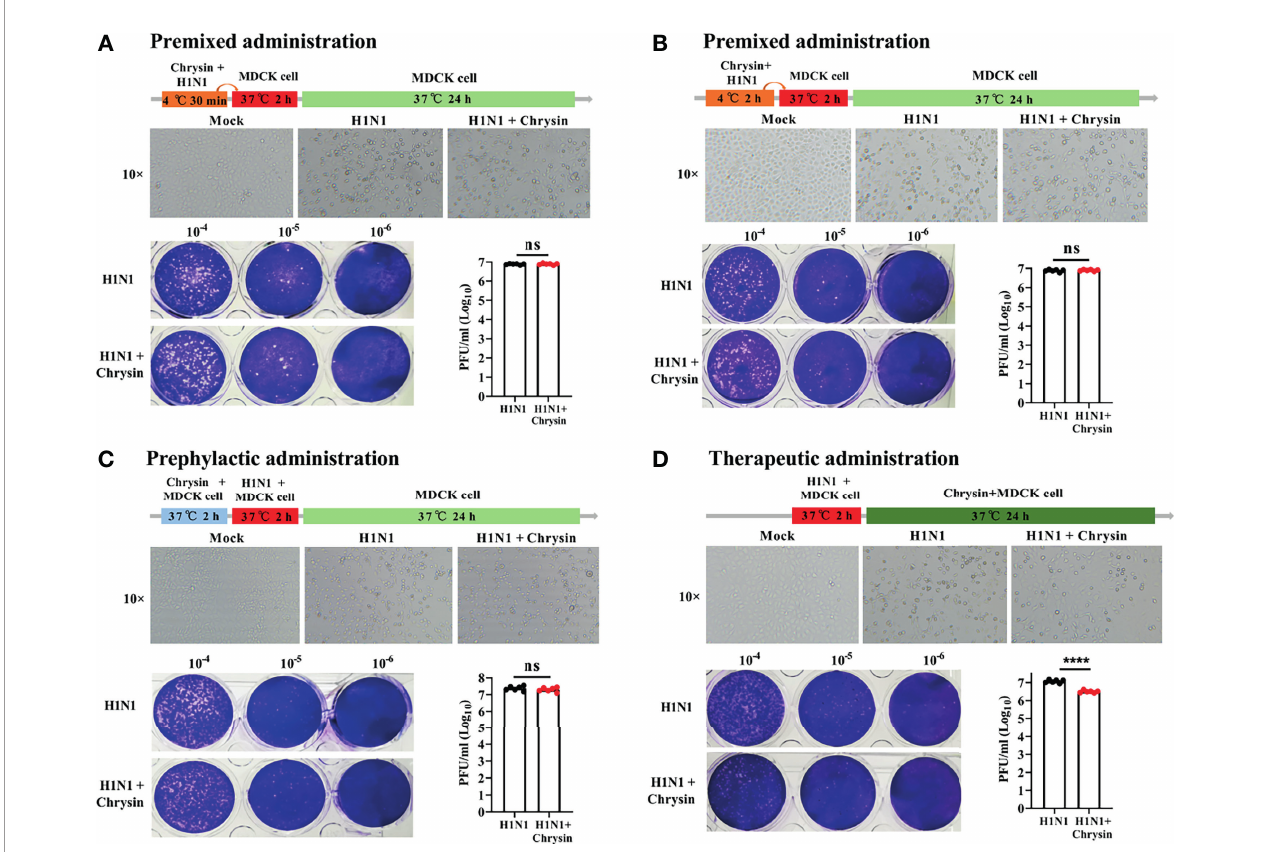
FIGURE 4 | Premixed, prophylactic, and therapeutic ef fi cacy of chrysin against the H1N1 in fl uenza virus. (A, B) Premixed administration. Chrysin (8 m M) and A/PR/ 8/34 (H1N1) virus (MOI = 0.5) were mixed and incubated at 4°C for 30 min (A) or 2 hours (B) , and then the mixture was inoculated onto MDCK cells at 37°C. After 2 hours of incubation, the supernatant was removed and replaced by medium for culturing 24 hours. CPE was observed under a microscope, 10 × original magni fi cation (upper panels). The Viral titer was detected by plaque assay (lower panels). (C) Prophylactic administration. MDCK cells were incubated with chrysin (8 m M) for 2 hours before being challenged with A/PR/8/34 (H1N1) virus (MOI = 0.5), after which the supernatant was removed and supplemented with fresh medium for culturing another 24 hours. CPE and viral titer were assessed using a microscope (upper panel) or a plaque test (lower panel), respectively. (D) Therapeutic administration. MDCK cells were infected with A/PR/8/34 (H1N1) (MOI = 0.5) at 37°C for 2 hours, then the supernatant was removed and cultured with new medium in the presence or absence of 8 m M chrysin for 24 hours before the CPE and viral titer were measured. All data are shown as the mean ± SEM of triplicate samples with a log value. When compared to the H1N1 control group, ****P < 0.0001 by unpaired two-tailed Student ’ s t-test. ns, no signi fi cant